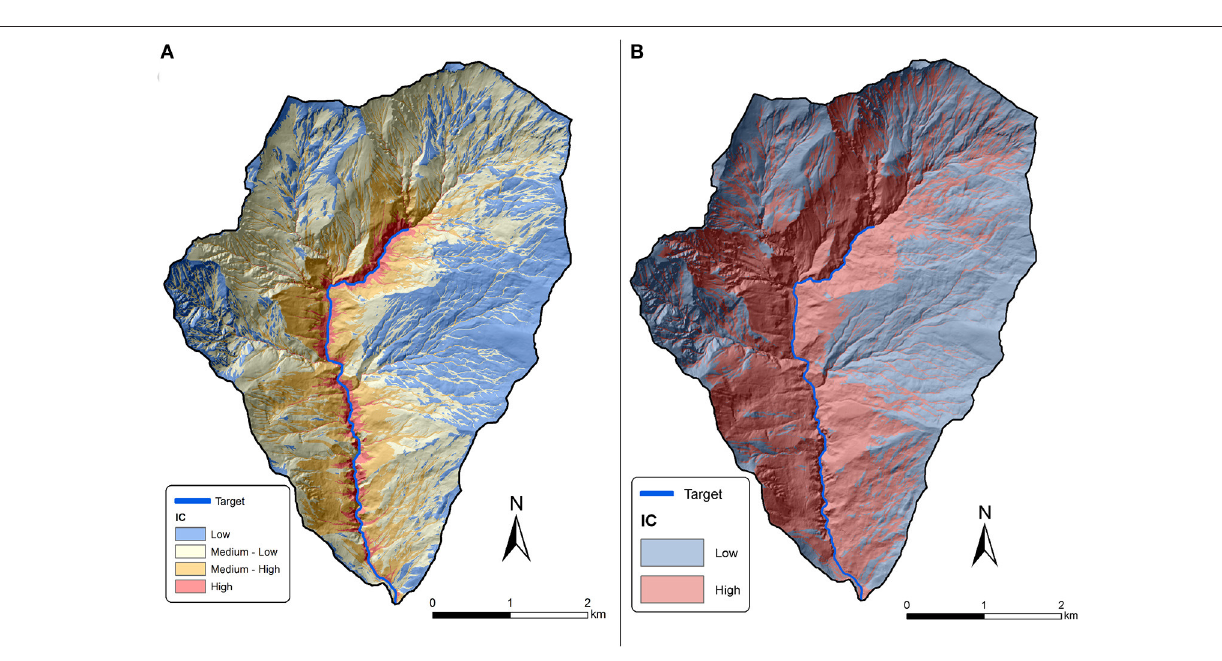
Frontiers in Earth Science |